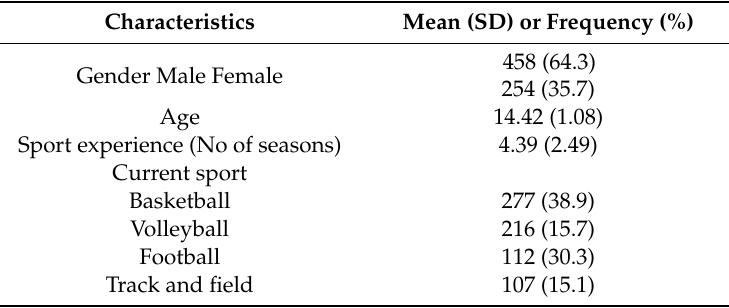
Table 1. Demographic characteristics of the study sample, N =